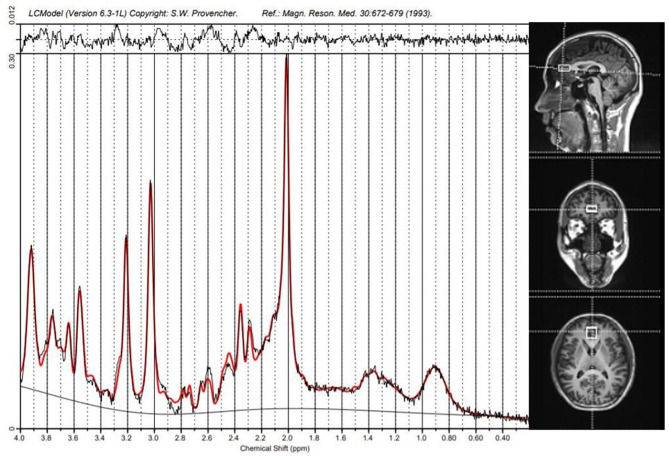
Spectroscopic voxel placement and proton magnetic resonance (1H-MRS) spectra. Voxel placement in the anterior cingulate cortex (ACC) and Sample 1H-MRS spectra acquired from ACC by LCModel.